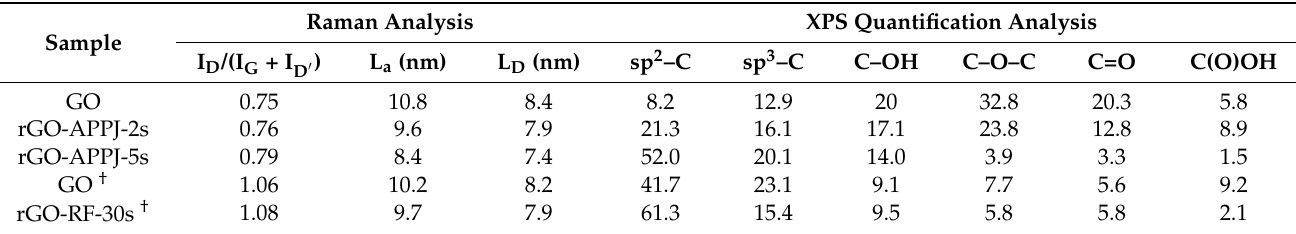
Figure 2. High-resolution XPS spectra in the C1s region for GO ( a ), 2 s APPJ reduced GO ( b ), 5 s APPJ reduced GO ( c ), and 30 s RF plasma reduced GO ( d ) on Si substrates. Table 1. The calculated values of I D /(I G + I D (cid:48) ), the average crystallite size (L a ), and the average distance between defects (L D ) for GO and various rGO from Raman spectroscopy (Figure 1 and Table S1). rGO-RF-30s and its reference GO sample (indicated by †) were measured with 633 nm laser excitation, while the remaining samples were measured with 532 nm laser excitation. Quantification (area distribution in %) of the components fitted in the C1s spectra (Figure 2). For the rGO-APPJ-5s sample, a contribution of 5.2% from the feature at binding energy >290 eV (discussed earlier) was not